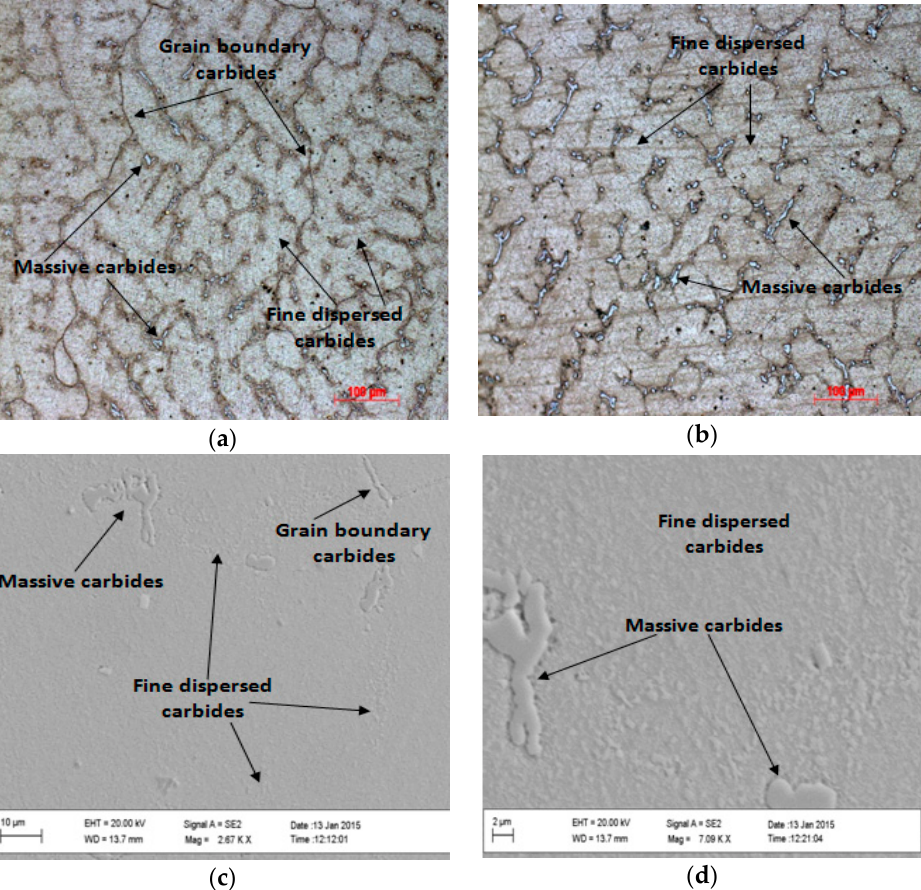
Figure 6. ( a ) Microstructure obtained after solution annealing at 1200 °C for 1.5 h followed by water quenching and aged at 760 °C for 24 h; ( b ) Sample solution annealed at 1200 °C for 3 h followed by water quenching and aged at 760 °C for 24 h. ( c ) SEM micrograph for the sample solution annealed for 1.5 h followed by water quenching and aged for 24 h; ( d ) The same sample at higher magnification.